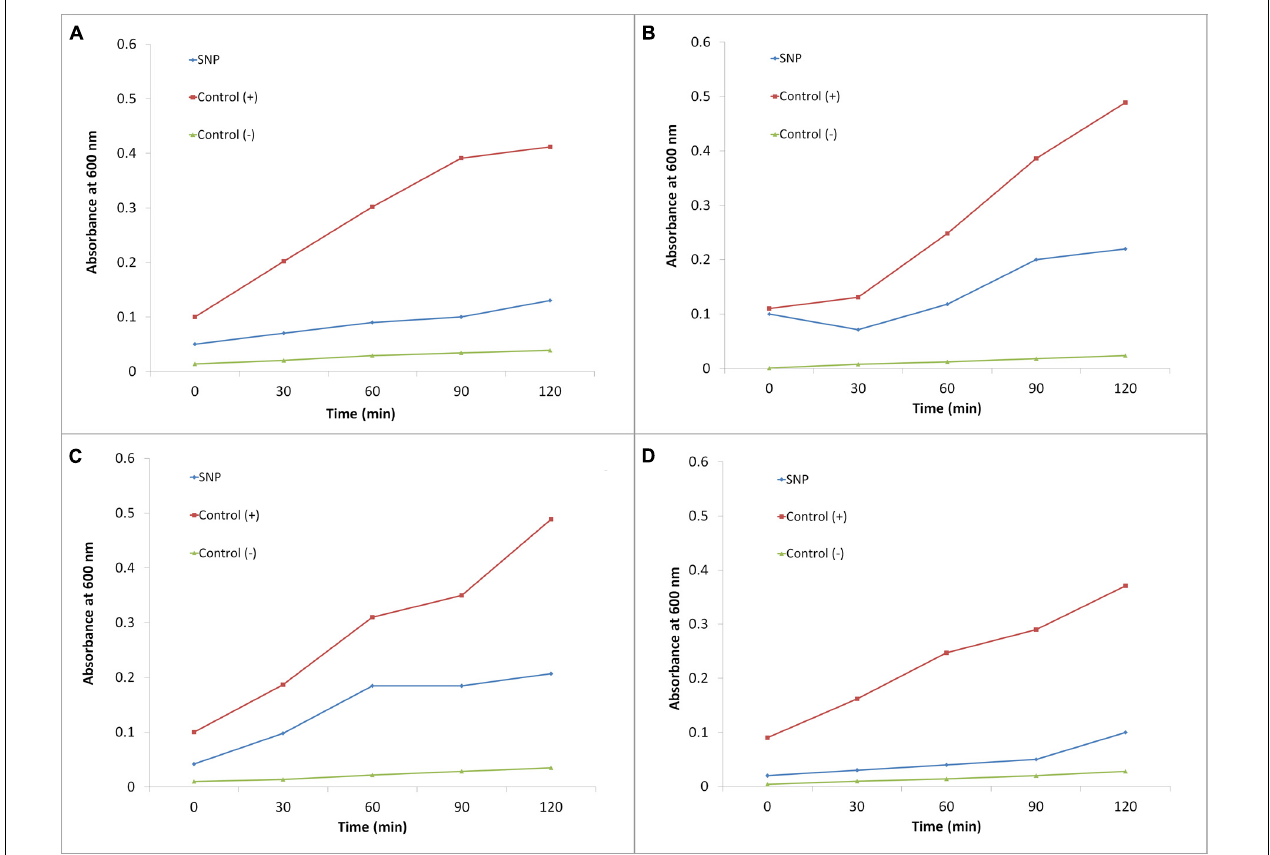
FIGURE 5 | Effect of SNPs on respiratory chain dehydrogenase activity in haloarchaea (A) Haloarcula argentinensis, (B) Haloarcula tradensis, (C) Haloferax lucentense , and (D) Haloferax